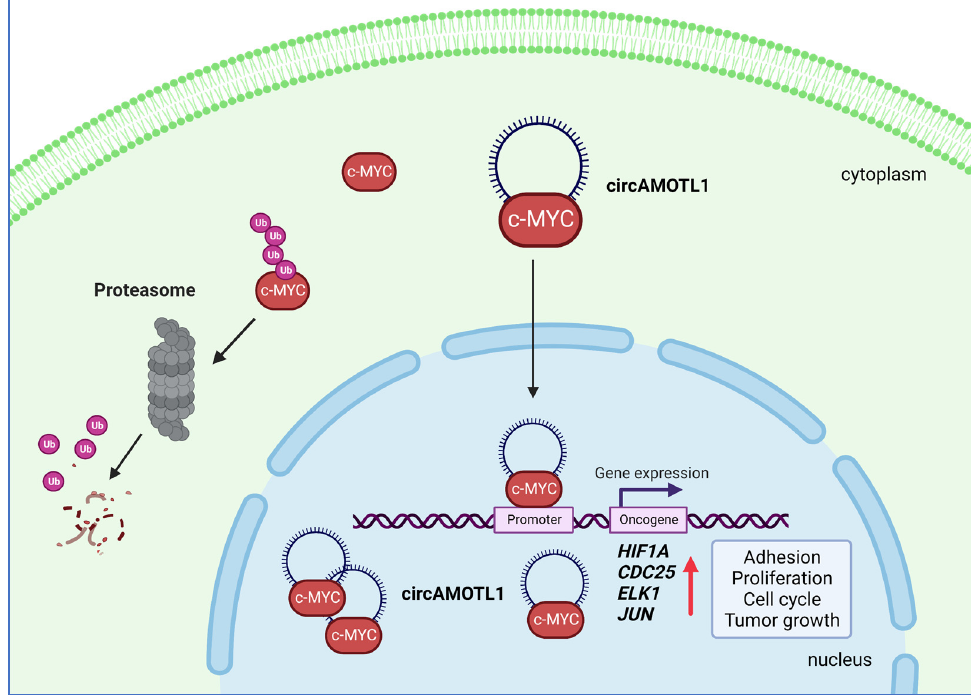
Figure 4. In breast cancer cells, circAMOTL1 binds c-MYC protein in the cytoplasm, facilitating translocation of the complex to the nucleus. In the nucleus, circAMOTL1 enhances the binding af- finity of c-MYC to multiple oncogene promoters (e.g., HIF-1 α , CDC25 , ELK1 , JUN ), promoting their expression and cancer growth. At the same time, interactions between circAMOTL1 and c-MYC prevent c-MYC degradation in the cytoplasm and enhance c-MYC stability in the